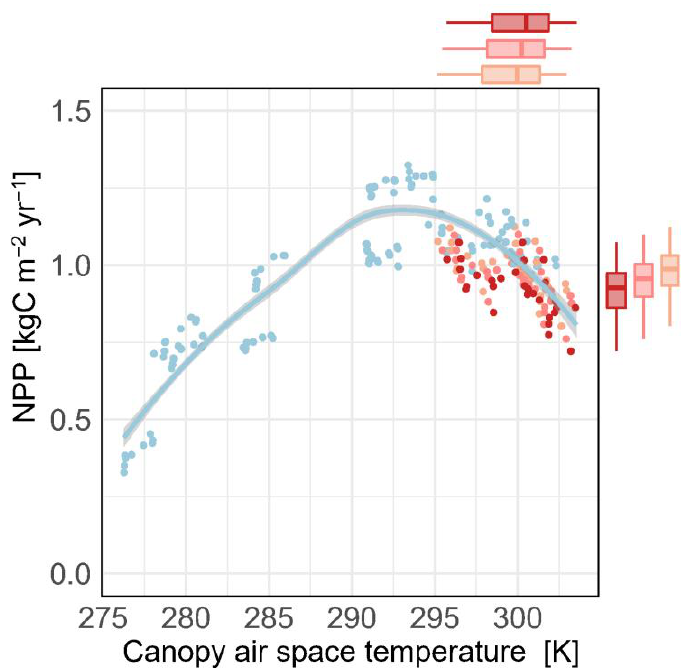
Figure 5. Relationships between canopy air space temperature [K] and NPP [kgC m − 2 yr − 1 ]. The blue points represent the NPP under the baseline scenario (B0) and before (January~May) and after (November~December, except for October) the warming scenarios. The light, moderate, and dark red points represent the NPP during (July~September) and after (only October) a mild (W1), moderate (W2), and severe (W3) warming scenarios, respectively. The boxplots on the top and right indicate the distributions of canopy temperature and NPP under three warming scenarios (W1, W2, and W3), respectively.